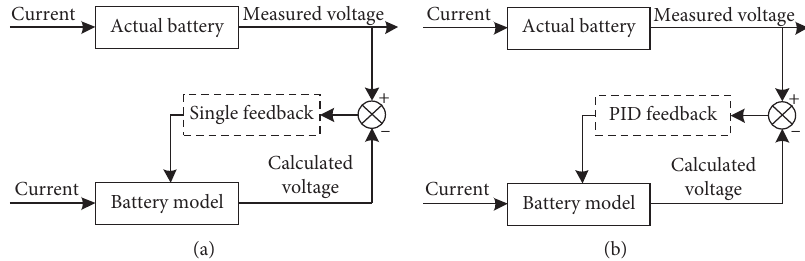
Figure 2: Block diagram of KF and improved KF. (a) KF with single feedback. (b) Improved KF with PID feedback.